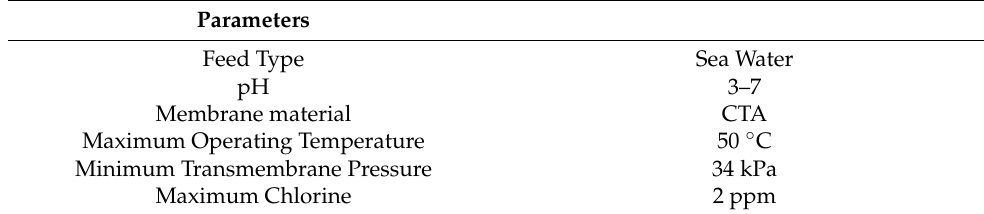
Table 3. FO membrane specification